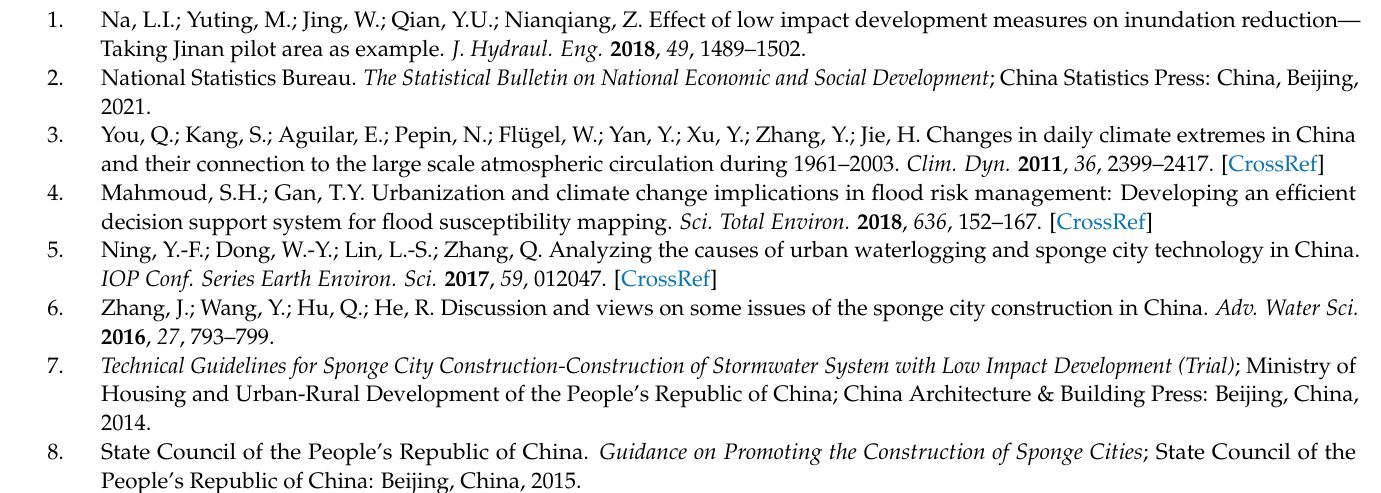
Figure S2: Model interface; Figure S3: Dynamic simulation diagram of the model; Figure S4: Diagram of flow interaction; Figure S5: River network and two-dimensional surface coupling model of a district in Chengdu; Figure S6: River network and two-dimensional surface coupling model of a district in Zhengzhou; Figure S7: River network and two-dimensional surface coupling model of a district in Jinan; Figure S8: Overview of technical research approach; Figure S9: The sub-catchment area; Figure S10: Slope gradient; Figure S11: The coupled 1D and 2D hydrodynamic model of the study